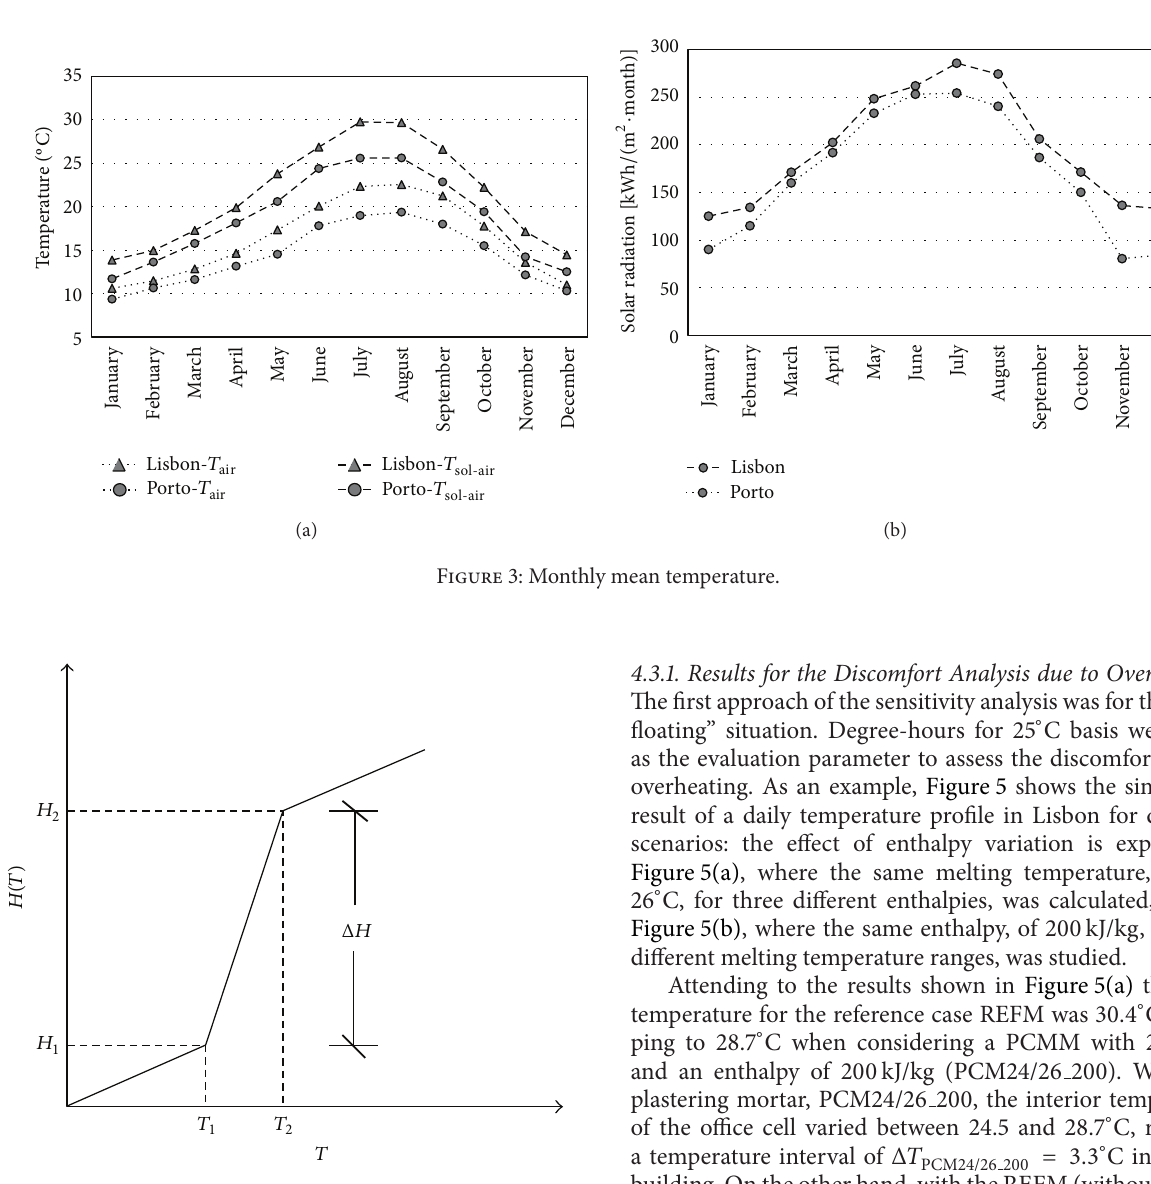
Figure 4: Enthalpy versus temperature.